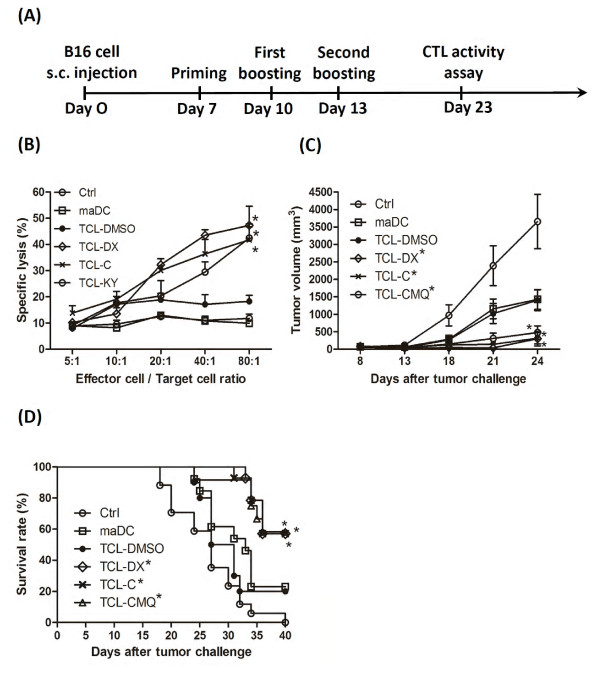
Therapeutic immunity of DC vaccines pulsed with various tumor cell lysates, against B16 melanoma. (A) Schematic representation for vaccination. C57BL/6 mice were challenged subcutaneously with 1 × 105 B16 cells and vaccinated with different preparations of TCL-pulsed DCs when the tumor volume reached to 50-80 mm3. On day 10 after the secondary boosting, splenocytes were harvested for cytotoxic T lymphocyte activity (CTL) assay. (B) CTL activities in test mice. Splenocytes from vaccinated or control group mice (n = 8 mice per group) were collected and CTL activity assayed with target tumor cells. Test DCs were pulsed with TCL-DMSO, TLC-DX, TLC-C, or TCL-CMQ. PBS-treated mice (Ctrl) did not receive DC vaccine, only a PBS injection. Test mice in the mature DC group (maDC) were subjected to vaccination with unpulsed mature DCs. (C) Tumor growth of treated mice. Tumor size of each group (n = 8 mice per group) was measured on indicated days. (D) Survival rates of treated mice. Survival of mice (n = 12 mice per group) was observed after tumor challenge. For all experiments, the TCL-FMQ groups showed a similar pattern of activities as that of TCL-CMQ and hence the data are not shown. All data are expressed as mean ± S.E.M.